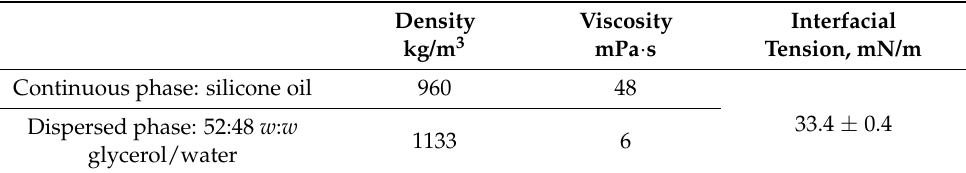
Table 1. Properties of continuous and dispersed phases.